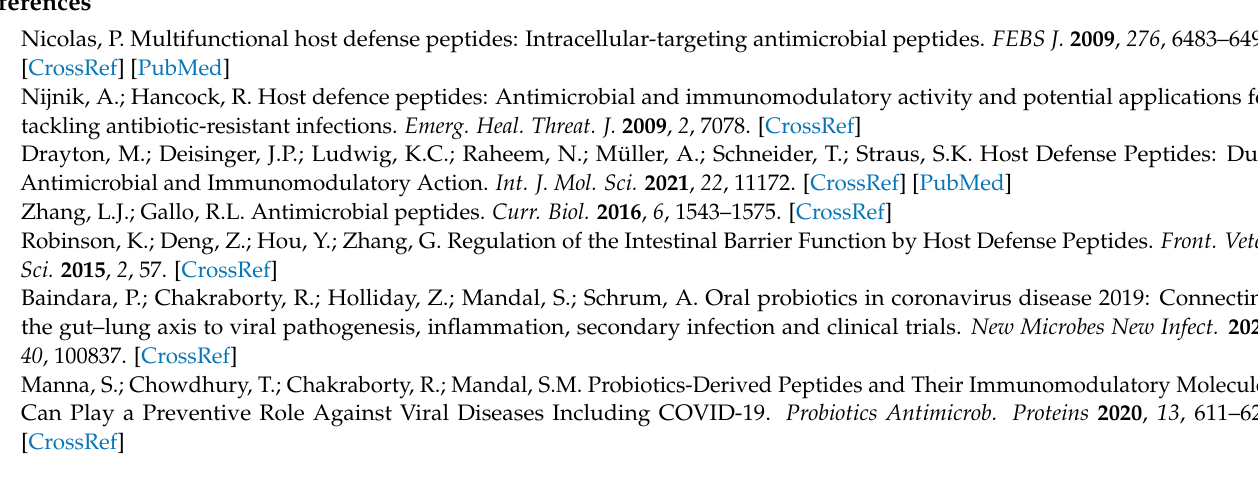
Figure S4: Regulatory and metatargetome analysis of module